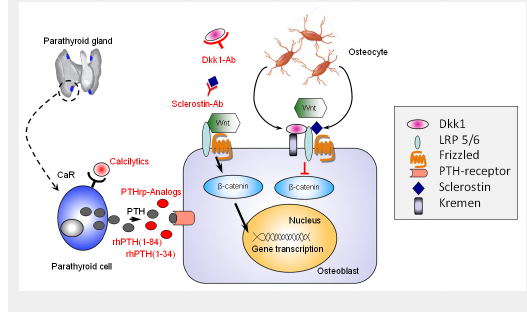
Targeting osteoblasts to stimulate bone formation. Recombinant human full length parathormone, rhPTH (1-84), its N- terminal segment rhPTH (1-34), and PTH related protein (PTHrp) analogues exert their bone anabolic effect after binding to the PTH receptor present on the osteoblasts. Calcilytics modulate PTH secretion by shifting the setpoint of the calcium-receptor (CaR) found on parathyroid cells. Sclerostin and Dickkopf-1 (dkk1) are endogenous inhibitors of the canonical Wnt-ß-catenin signaling pathway. Monoclonal antibodies directed against sclerostin or dkk1 induce an intracellular accumulation of ß-catenin followed by increased gene transcription which ultimately results into stimulation of osteoblastic bone